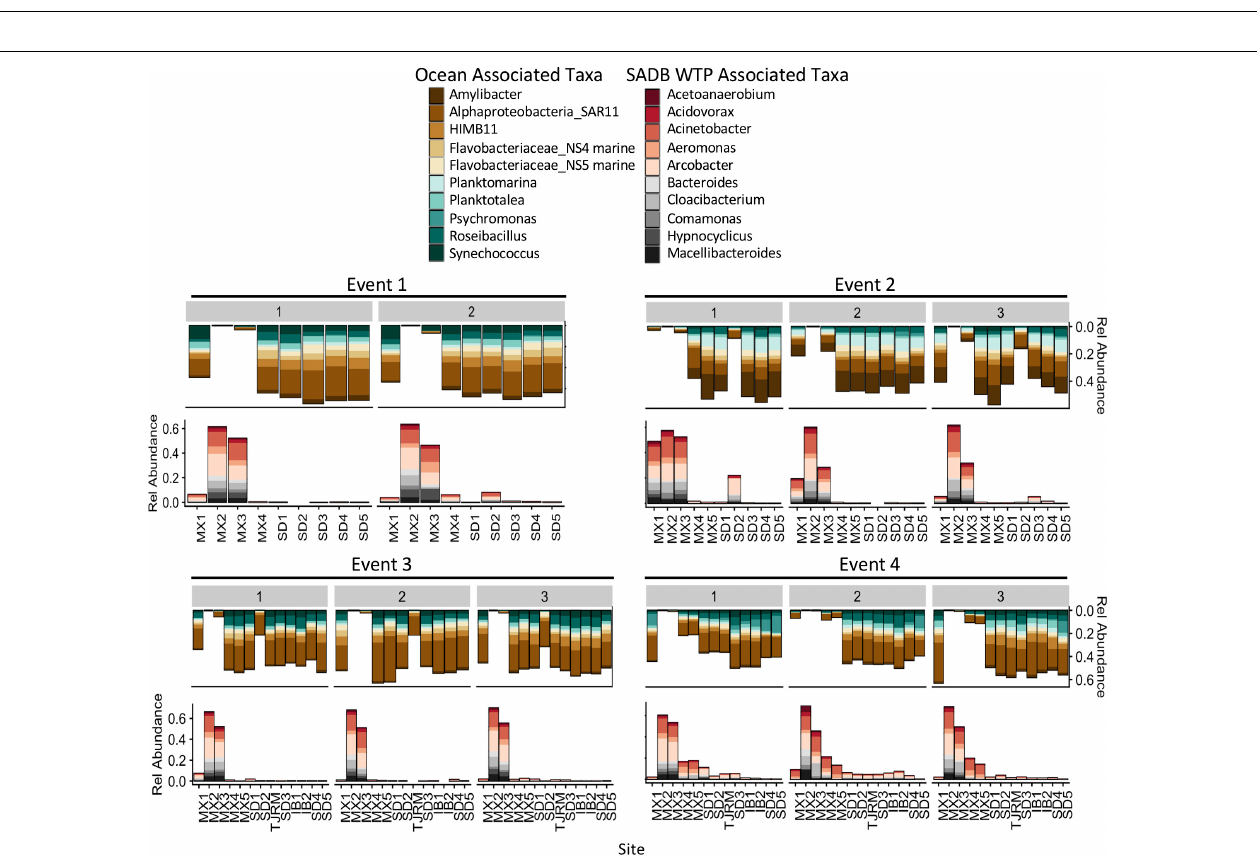
FIGURE 6 | Relative abundances for the 10 most abundant families and genera associated with SADB WTP effluent stream (MX2) and Silver Strand (SD5) samples- representing the unimpacted marine microbial community. Relative abundances are shown at all sites moving south to north along the x -axis. Marine associated taxa are presented on the top and SADB WTP associated taxa are presented on the bottom.